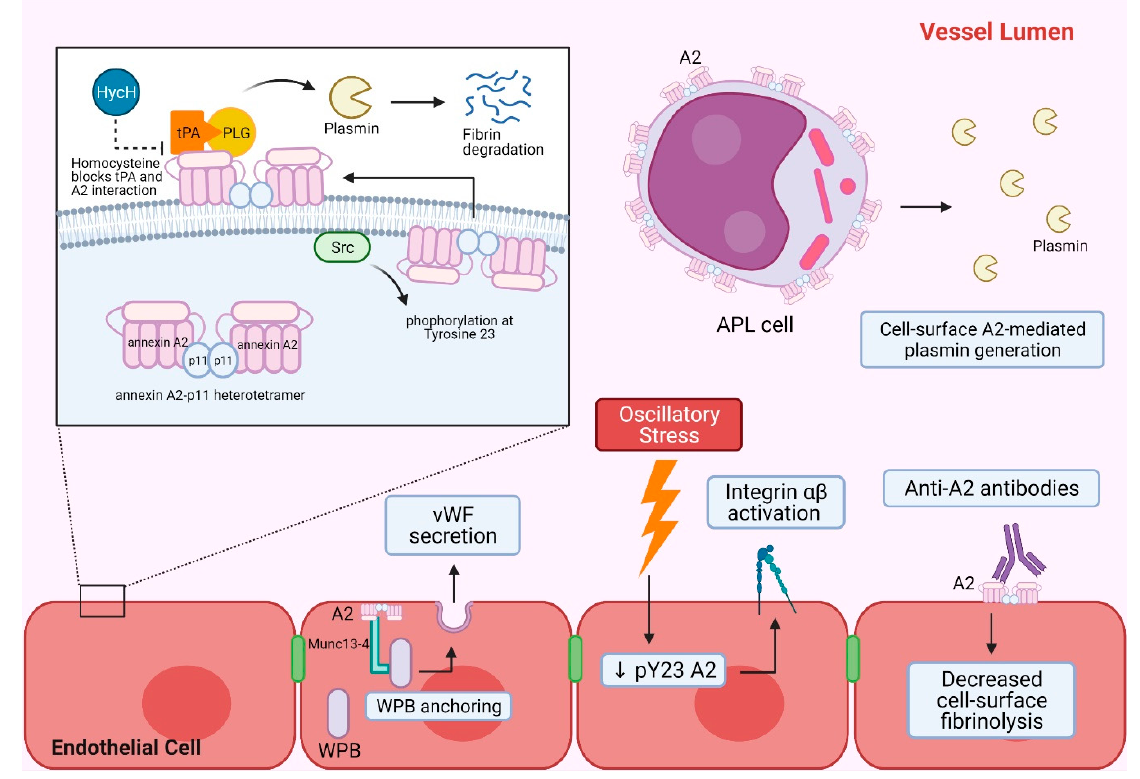
Figure 1. A summary of A2-mediated hemostasis and vascular homeostasis. A2 heterotetramer and its main cell surface fibrinolytic function are shown in the top left panel. A2 forms a heterotetramer with p11 intracellularly and associates with the inner leaflet of the phospholipid bilayer of the plasma membrane. When A2 is phosphorylated at tyrosine 23 by Src kinase, the heterotetramer is translocated to the extracellular membrane and functions as a tPA and PLG receptor for efficient plasmin generation leading to fibrin degradation. Homocysteine can block the interaction between tPA and A2, and decrease A2-mediated plasmin generation. The top right shows APL cells with increased cell surface A2, which can lead to increased plasmin generation and unopposed fibrinolysis. The bottom section shows other roles of A2 in endothelial cells that contribute to hemostasis. A2 facilitates WPB anchoring and subsequent exocytosis of its content by interacting with Munc13-4. WPB exocytosis results in vWF secretion. Oscillatory stress on endothelial cells can downregulate phosphorylated A2, which in turn activates integrin αβ . Autoantibodies against A2 have been shown to bind to extracellular surface A2 and decrease cell surface fibrinolysis. A2 = annexin A2, APL = acute promyelocytic leukemia, HycH = Homocysteine, p11 = S100A10 protein, pY23 A2 = phosphorylated annexin A2, PLG = plasminogen, Src = Src kinase, tPA = tissue plasminogen activator, vWF = vonWillebrand factor, WPB = Weibel–Palade body.